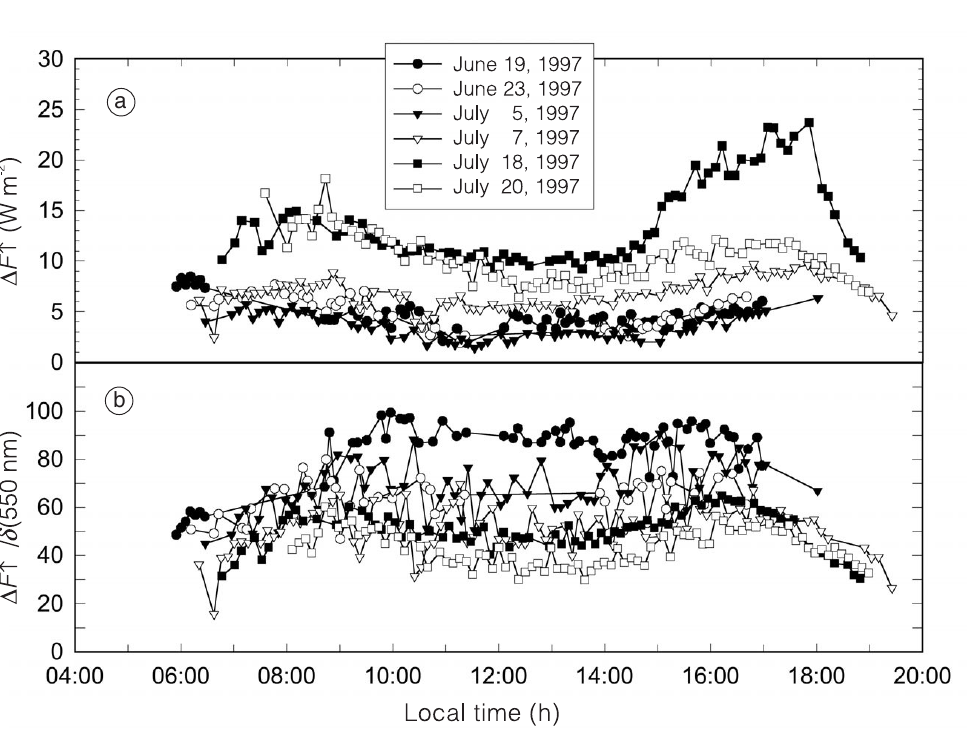
Fig. 4a,b. a) Time-patterns of the change D F (cid:112) in the upwelling solar radiation fl ux at the top of the atmosphere, determined for the six selected days considered in fi g. 3a,b. b) Time-patterns of change D F (cid:112) / d (550 nm) per unit variation of AOD at the mean visible wavelength, determined for the same six